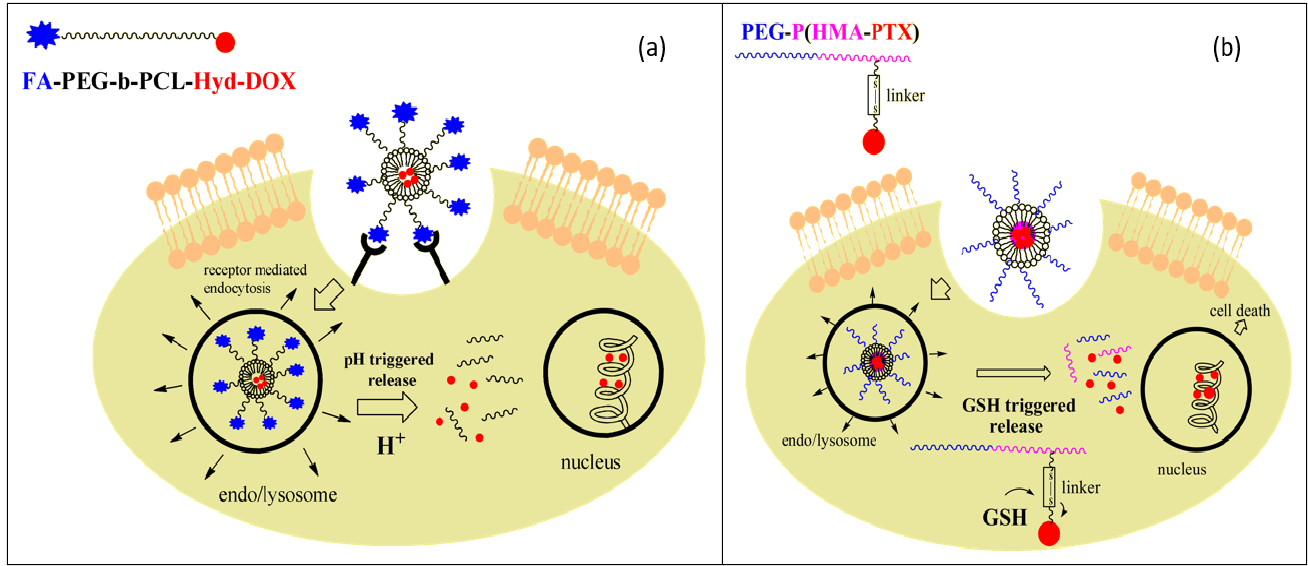
Figure 5. ( a ) Mechanism of action of pH-responsive polymer NPs, decorated with targeting ligand folic acid (FA) and with doxorubicin, bound via a hydrazone bond to diblock copolymer PEG-PCL. ( b ) Mechanism of action of redox-responsive polymer NPs with bonded paciltaxel via a disulfide linker to diblock copolymer PEG-b-PHEMA. Adapted from an open- access source [22].